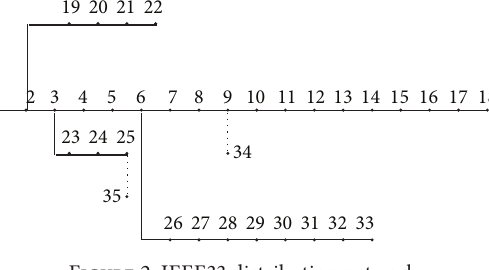
Figure 2: IEEE33 distribution